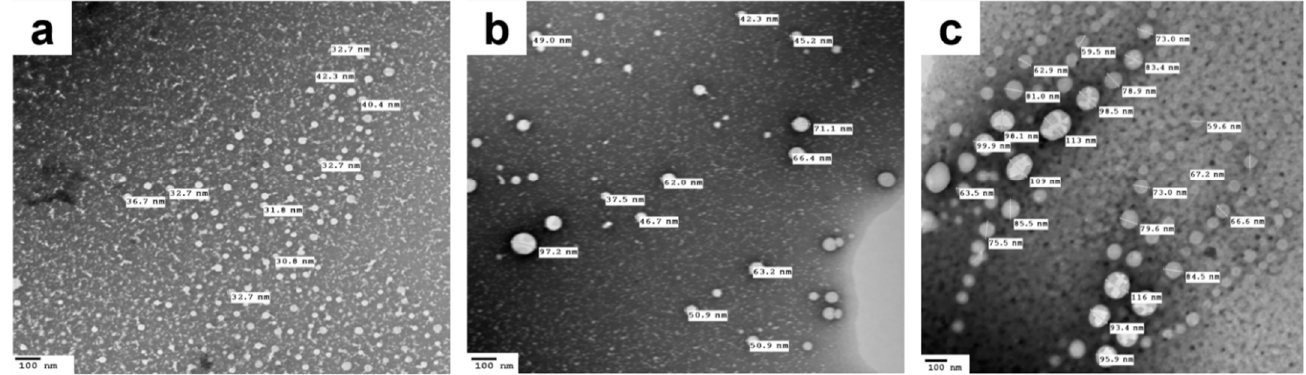
Figure 2. TEM images showing oil droplets of ( a ) C3 TD , ( b ) C4 TD and ( c ) P2 TD NEs after 50-fold dilution with saline.